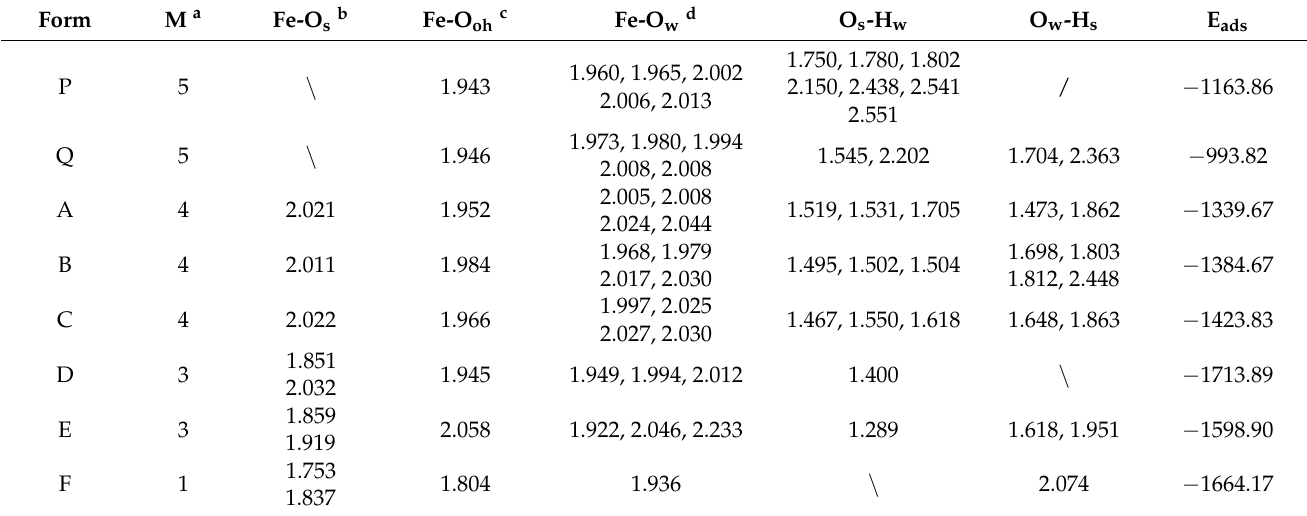
Table 5. Bonds length (Å) and energies (KJ/mol) of the compounds.